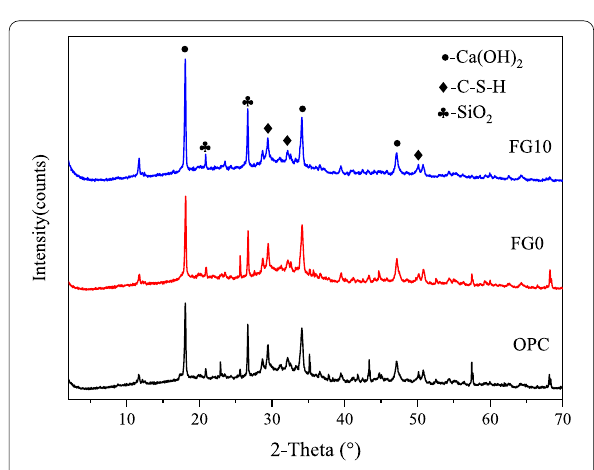
Fig. 4 XRD patterns of OPC, FG0, and FG10 at 28